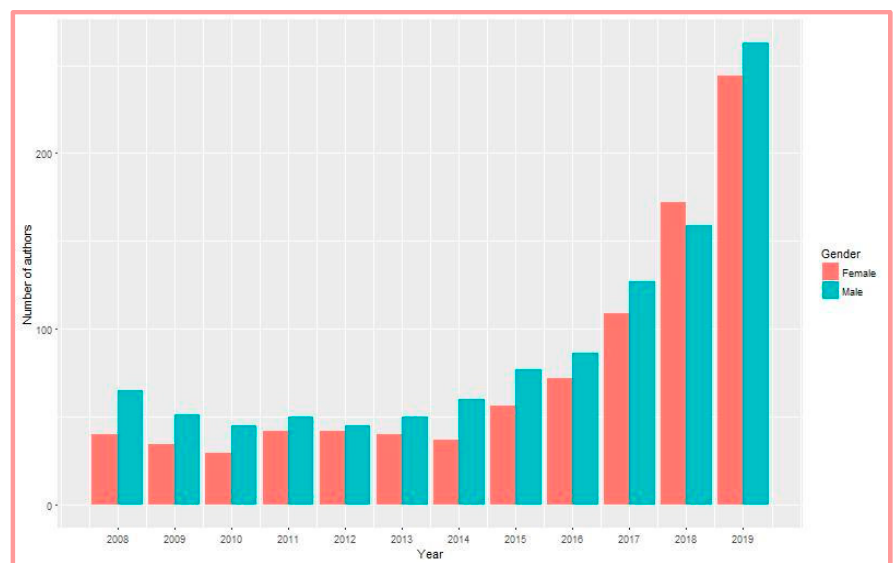
Figure 3. Number of “new” Vietnamese authors participating in SSH research by gender in the period